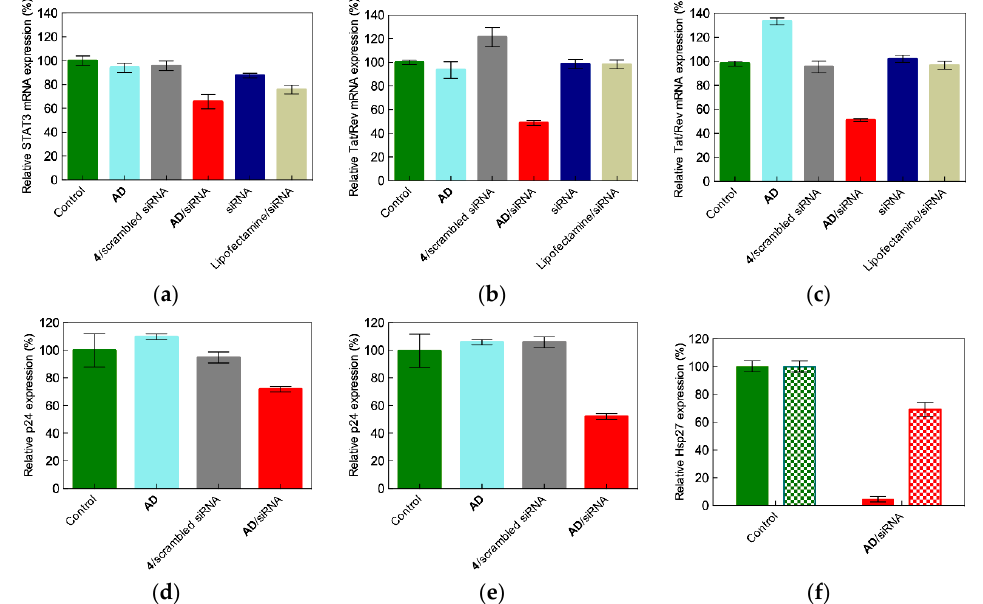
Figure 11. ( a ) STAT3 knockdown in glioblastoma stem cells (PBT003) treated with siRNA/ AD complexes (50 nM siRNA, N/P = 5). The knockdown of Tat/Rev in primary human peripheral blood mononuclear cells (PBMC-CD4 + ) ( b ) and hematopoietic CD34 + stem cells (HSC-CD4 + ) ( c ) treated as in ( a ). Effective inhibition of HIV replication in PBMC-CD4 + ( d ) and HSC-CD4 + ( e ) after treatment with the anti-Tat/Rev siRNA delivered by AD (50 nM siRNA, N/P = 5). Viral loading was assessed using HIV-1 p24 antigen ELISA 3 days post-treatment. PBMC-CD4 + cells and HSC-CD34 + cells were infected by NL4-3 virus at a multiplicity of infection (MOI) = 0.001 and by JR-FL virus (MOI = 0.005), respectively, for 5 days before transfection. ( f ) Proton-sponge effect in PC-3 cells transfected with siRNA/ AD in the absence (solid bars) and presence (patterned bars) of the proton pump inhibitor Bafilomycin A1. Untreated cells were used as the control. Adapted from [6] with permission of John Wiley and Sons, 2014.